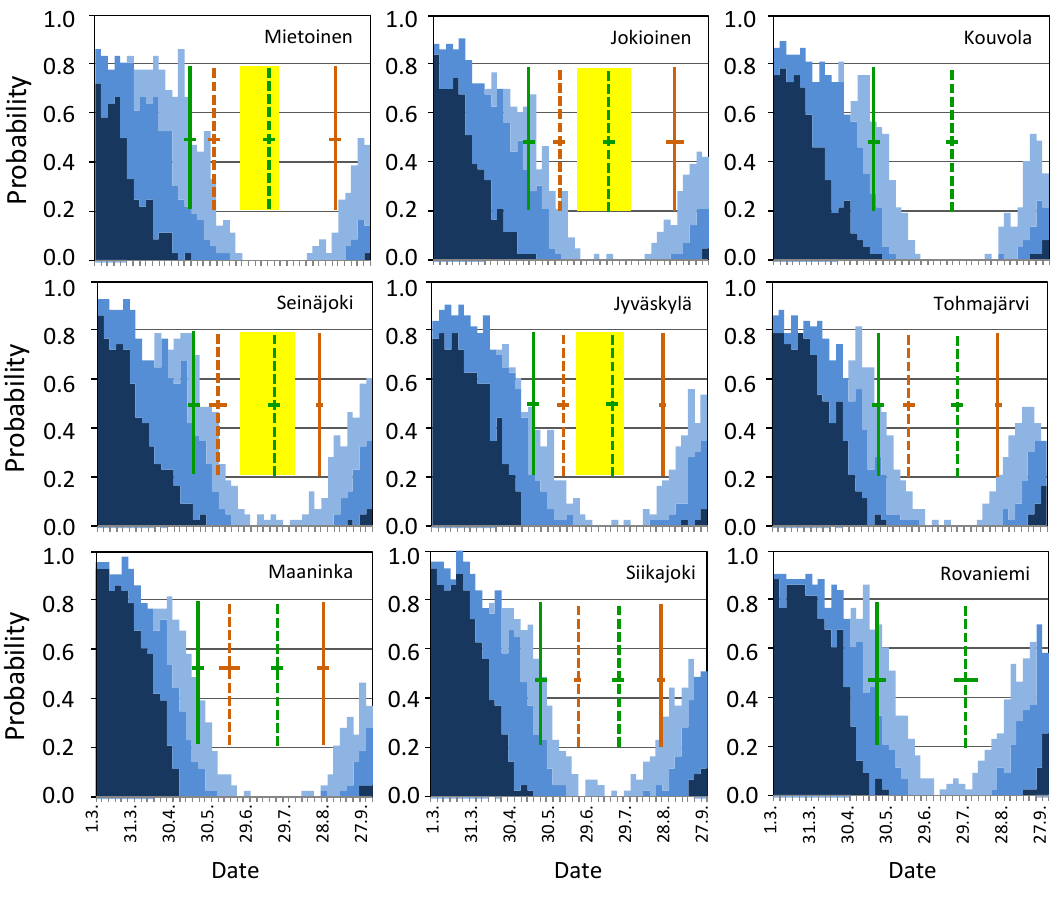
Fig. 2. Risk probabilities of night frost from 1 March to the end of September at nine locations in Finland. Light blue indicates mild (–2 to –5 °C), blue moderate (≤ –5 °C) and dark blue severe (≤ –9 °C) night frost. Green solid line indicates mean sowing time and green dashed line heading in spring cereals and the orange lines those for winter cereals. Yellow highlighted area indicates duration of flowering in rapeseed when appropriate. Latitudes and longitudes of each location are given in Table